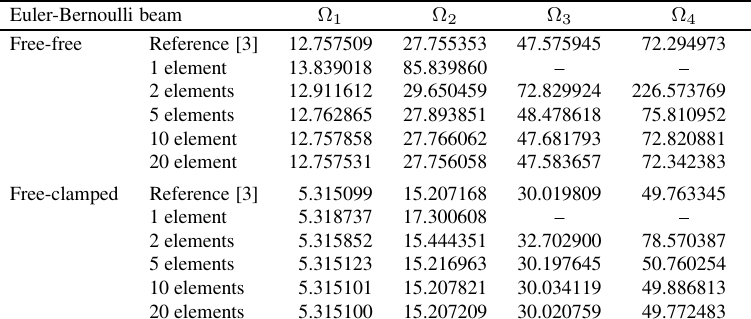
Table 2 First four natral fequencies of a wedge beam with constant width and linearly tapered